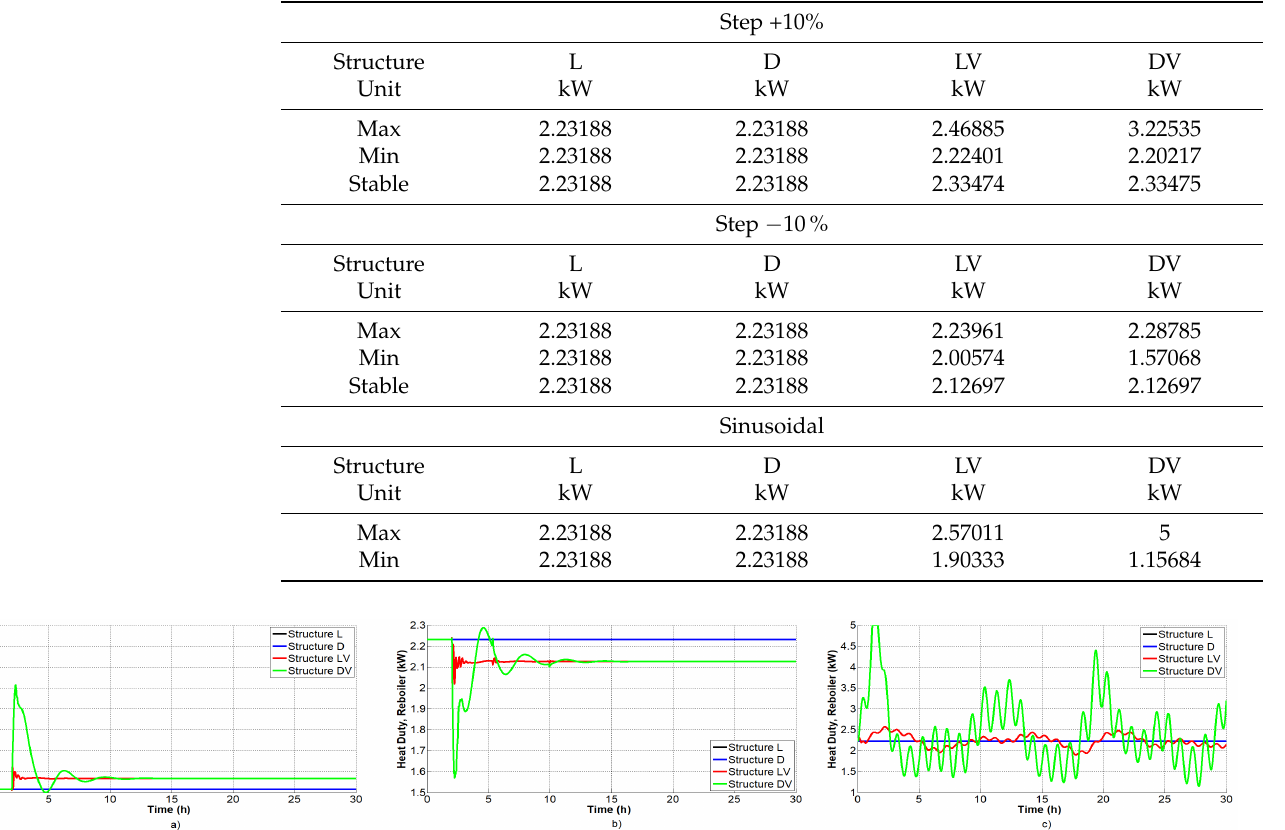
Figure 17. Power consumption of the reboiler using the control structures L, D, LV, and DV, with disturbances in the composition of the feed: ( a ) step of 10%, ( b ) step of − 10%, and ( c ) fluctuating sinusoidal